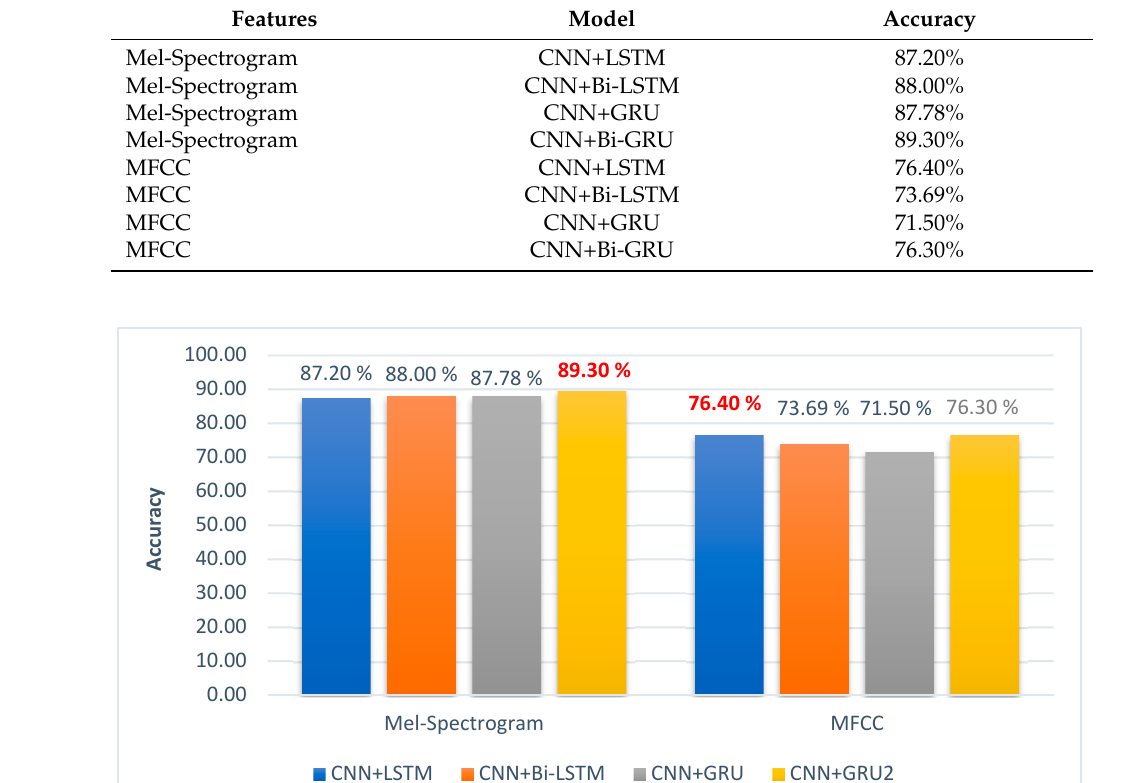
Table 3. Comparison between the proposed hybrid model and the other state-of-the-art models. Table 2. Results of extracted features with proposed hybrid architecture.